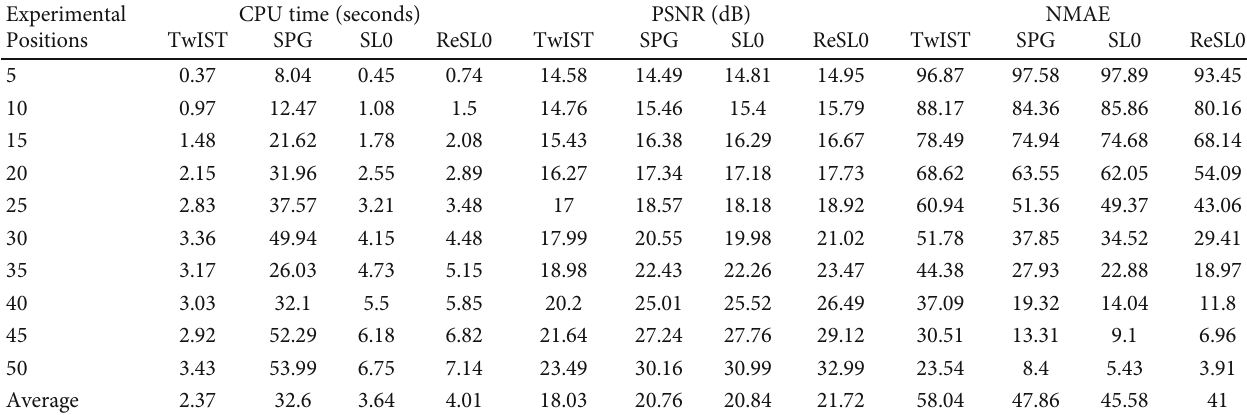
Table 3: Numerical results of reconstructed